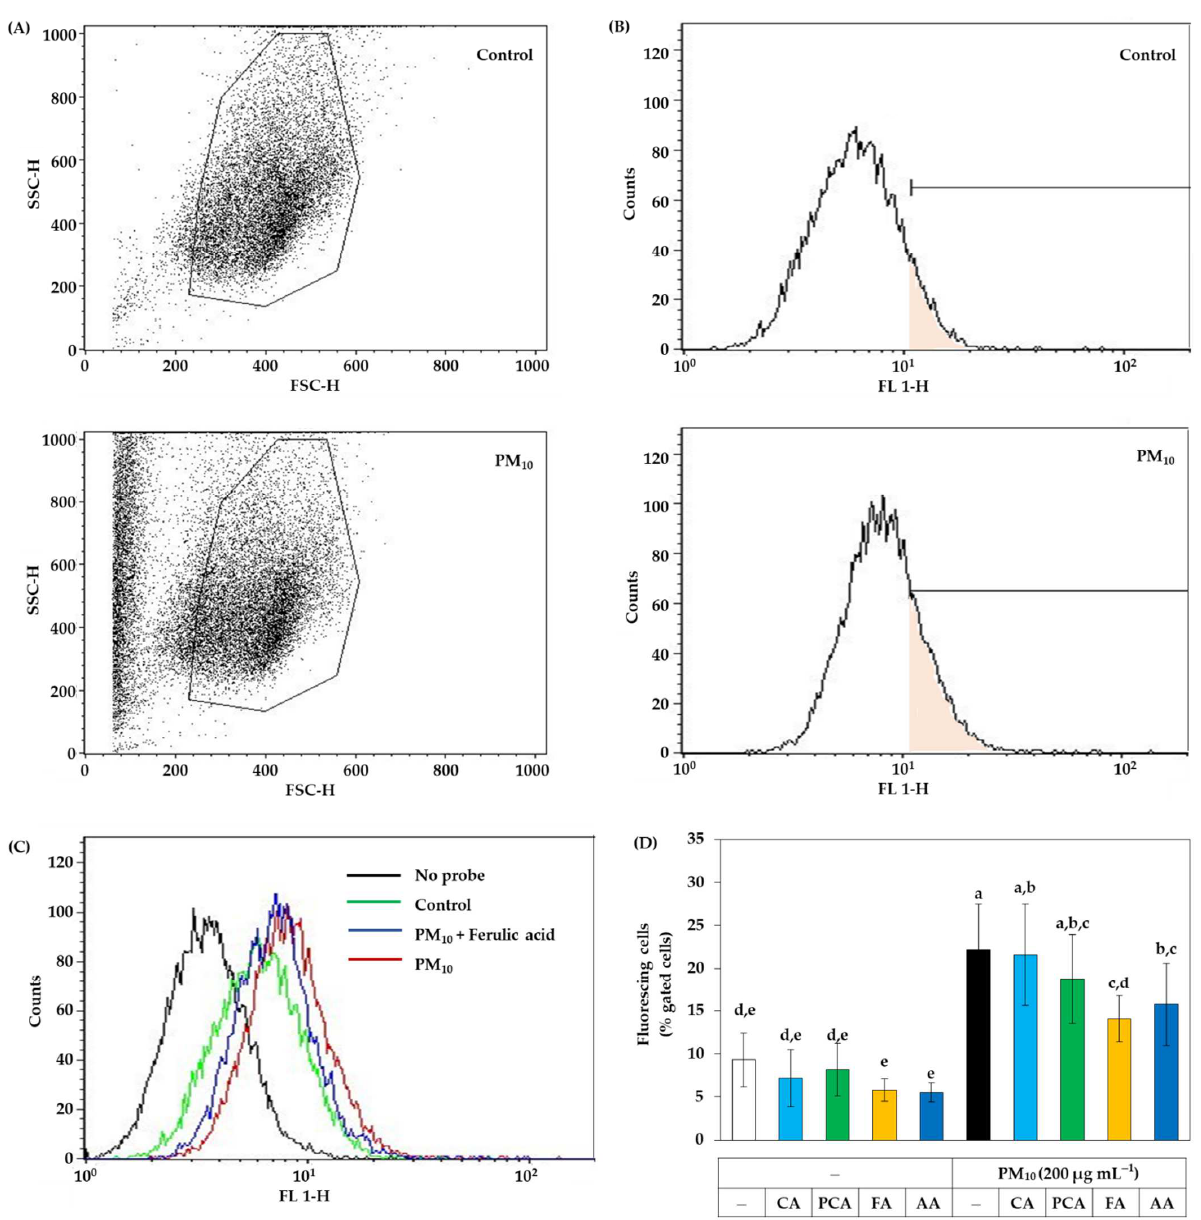
Figure 7. Flow cytometry for the ROS production in HaCaT keratinocytes exposed to PM 10 in the absence and presence of caffeic acid (CA), p- coumaric acid (PCA), ferulic acid (FA), and ascorbic acid (AA). The adherent cells were labeled with DCFH-DA, treated with vehicle or each compound at 30 μM, and exposed to PM 10 (200 μg mL −1 ) for 60 min or not. Cells were washed, detached, centrifuged down, and suspended in PBS for flow cytometry. ( A ) The gate was set to exclude the PM 10 particles and cell aggregates. ( B ) The plots of the cell counts versus fluorescence intensity are shown with a mark to define fluorescing cells. ( C ) Typical effects of PM 10 in the absence and presence of FA on the distribution of cells with different fluorescence levels. ( D ) The ratios (%) of fluorescing cells to the total gated cells are presented. Data represent mean ± SD ( n = 3). Duncan’s multiple range test was performed to compare all group means to each other. Groups that share the same letters (a–e) do not have significantly different means at the p < 0.05